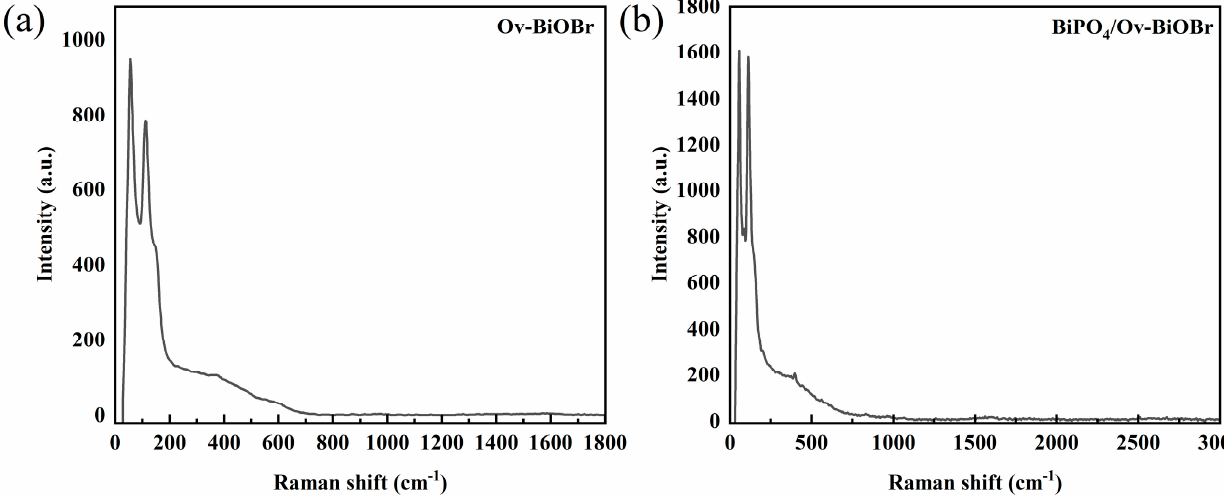
Figure 4. Raman spectra of Ov-BiOBr ( a ) and BiPO 4 /Ov-BiOBr ( b ).